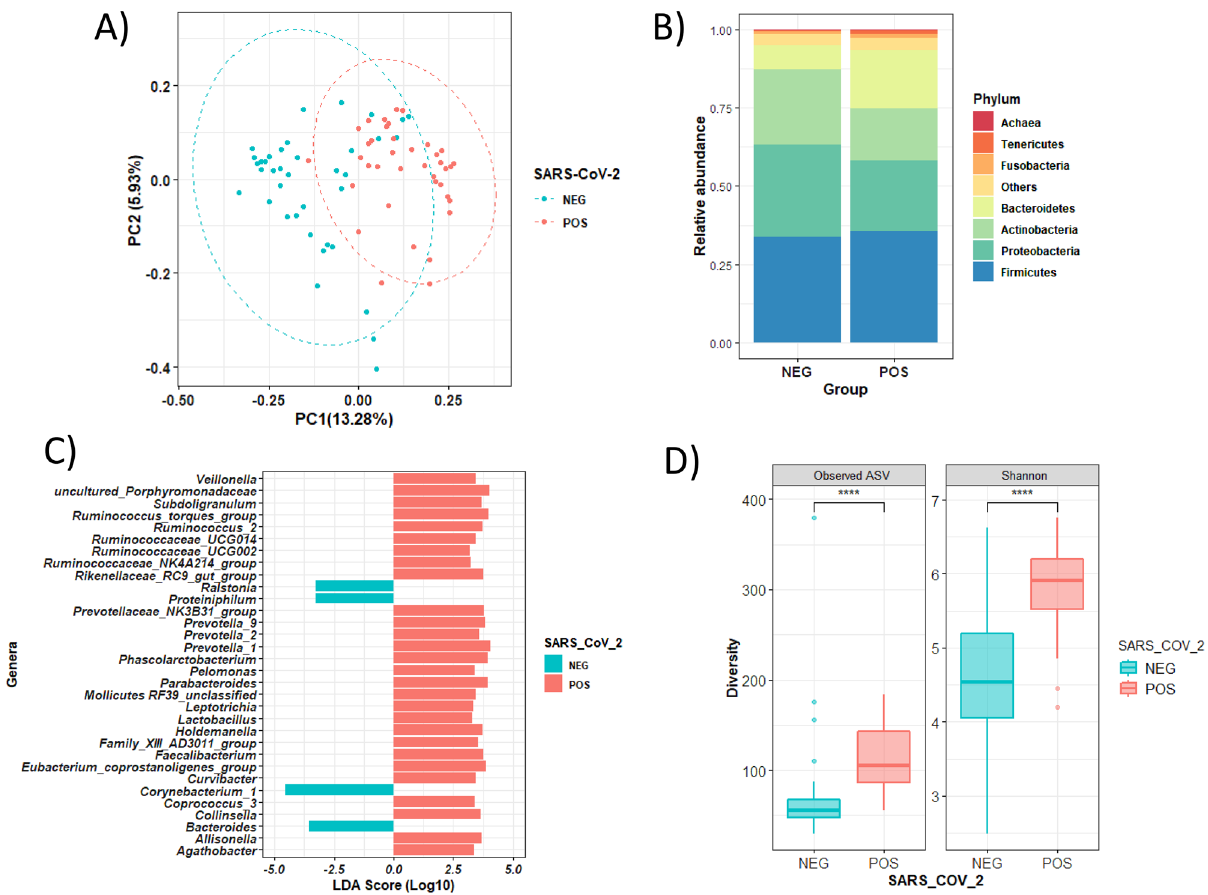
Figure 1. The nasopharyngeal microbiota of pregnant women is altered by SARS-CoV-2 infection. ( A ) Principal coordinates analysis (PCoA) ordination plot based on unweighted UniFrac distances according to SARS-CoV-2 infection. Each point corresponds to a sample. ( B ) Barplots showing the composition of the nasopharyngeal microbiota of the population in healthy (NEG) and SARS-CoV-2-infected (POS) pregnant women. Phyla with a relative abundance lower than 0.5% and Cyanobacteria were grouped as “Others” for plotting. ( C ) LDA effect size (LEfSe) analysis showing the genera that most discriminate both health conditions (infected vs. no infected). An LDA score > 3 was considered a significant threshold. ( D ) Boxplots showing the differences in the alpha diversity measured as observed ASV (amplicon sequence variant) and Shannon indexes according to SARS-CoV-2 infection. Statistical analysis of the differences between groups was calculated using the Kruskal–Wallis test with FDR correction for multiple comparisons. POS Positive result for SARS-CoV-2 (red), NEG negative result for SARS-CoV-2 (blue). * p < 0.05; ** p < 0.01; *** p <